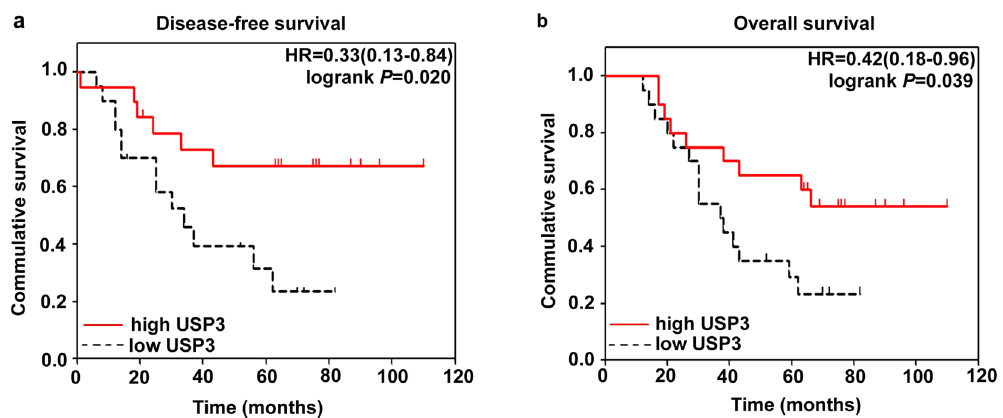
Figure 6. Kaplan-Meier curves for the disease-free survival and overall survival of the 40 CRC patients. High USP3 mRNA expression was notably correlated with favourable DFS ( a ) and OS ( b ) in the CRC